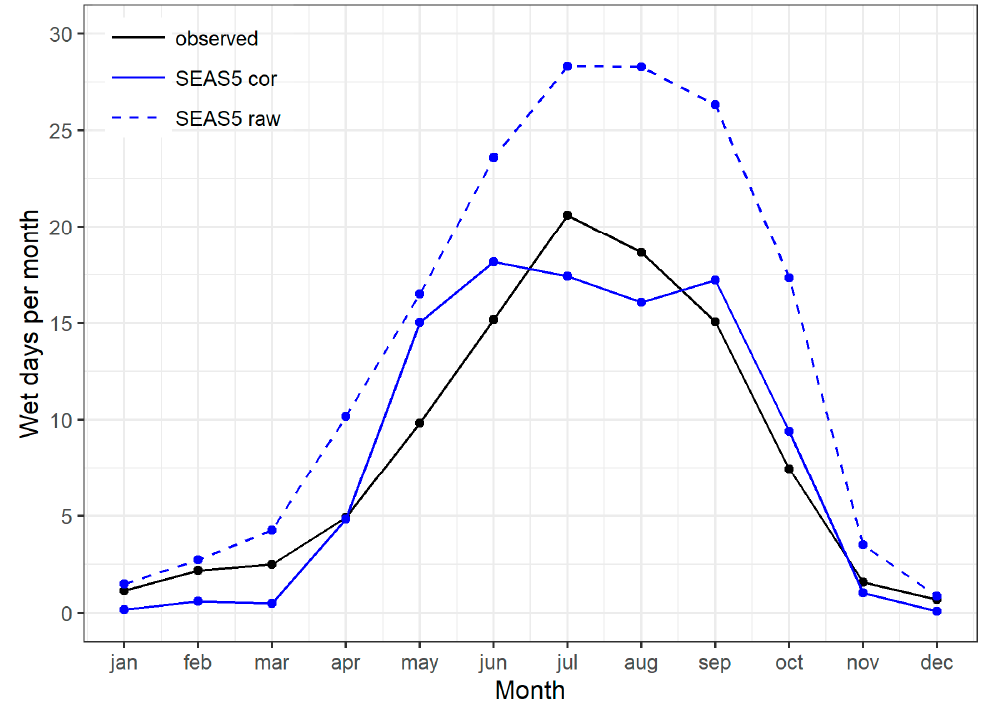
Figure 3. Mean monthly climatology of wet days per month for the period 1981–2016 of the raw and the bias-corrected SEAS5 hindcasts in relation to observations for Khulna station.